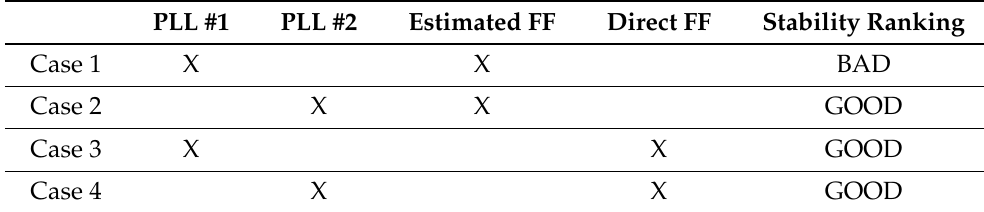
Table 5. Study cases: influence of the PLL and the feedforward